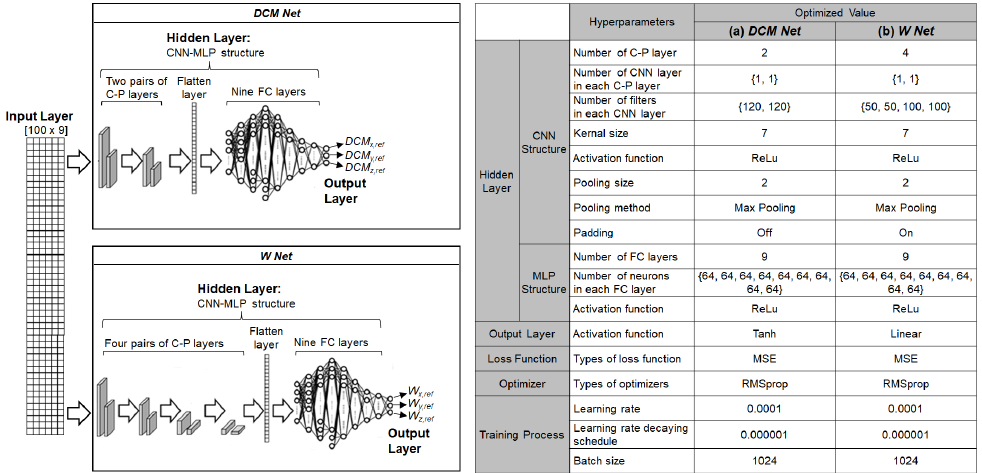
Figure 12. Structures of DCM Net and W Net for the behavior cloning model used in actual robot: hyperparameters for ( a ) DCM Net and ( b ) W Net.